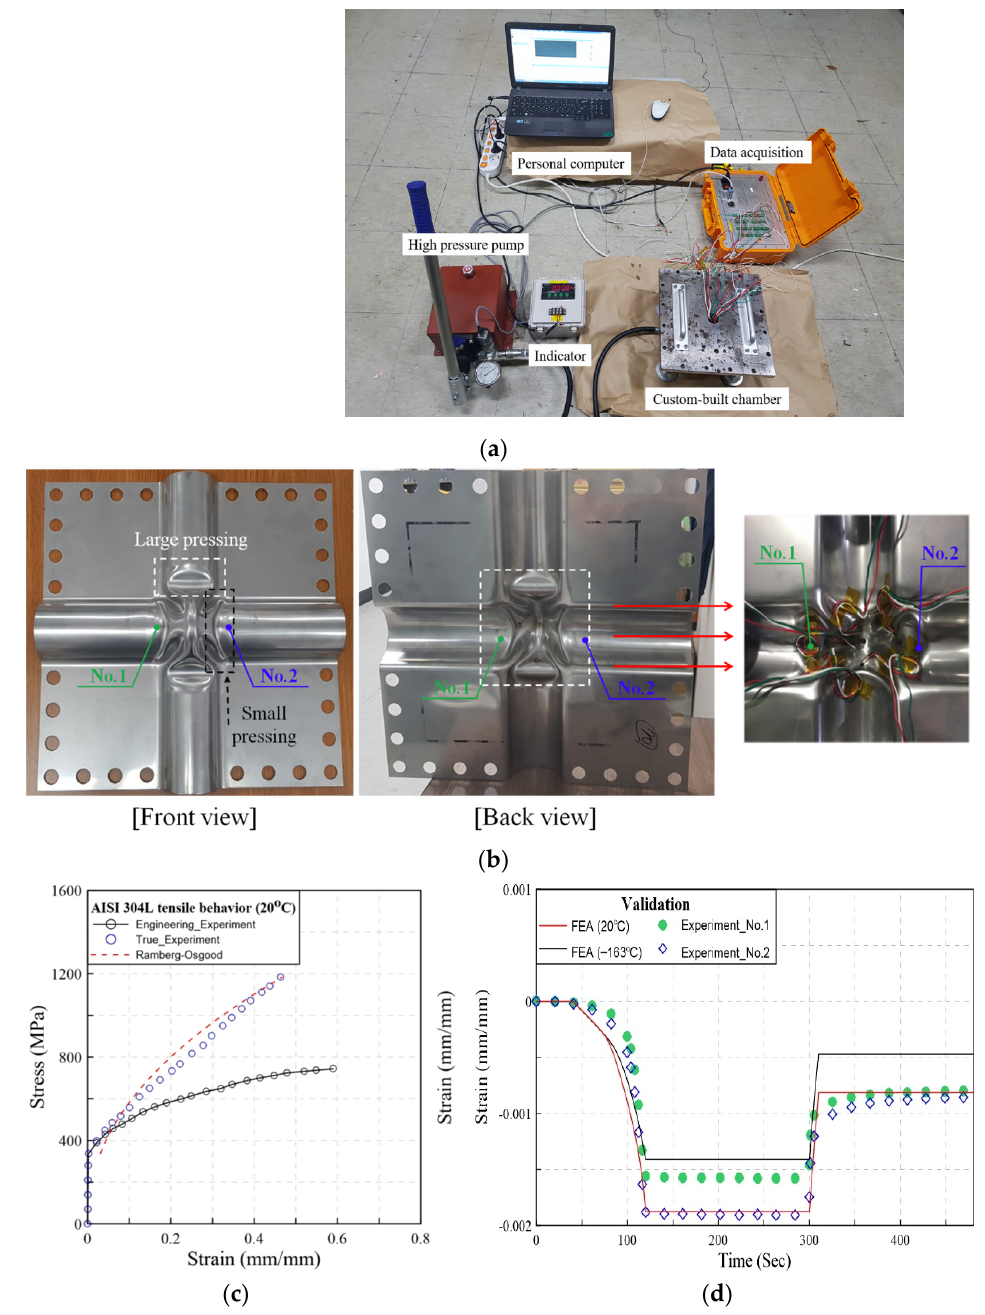
Figure 7. Photographs of the ( a ) experimental apparatus and ( b ) strain measurement points at the primary barrier; graphs depicting the ( c ) tensile properties of AISI 304L at room temperature and ( d ) experimental and FEA time–strain histories